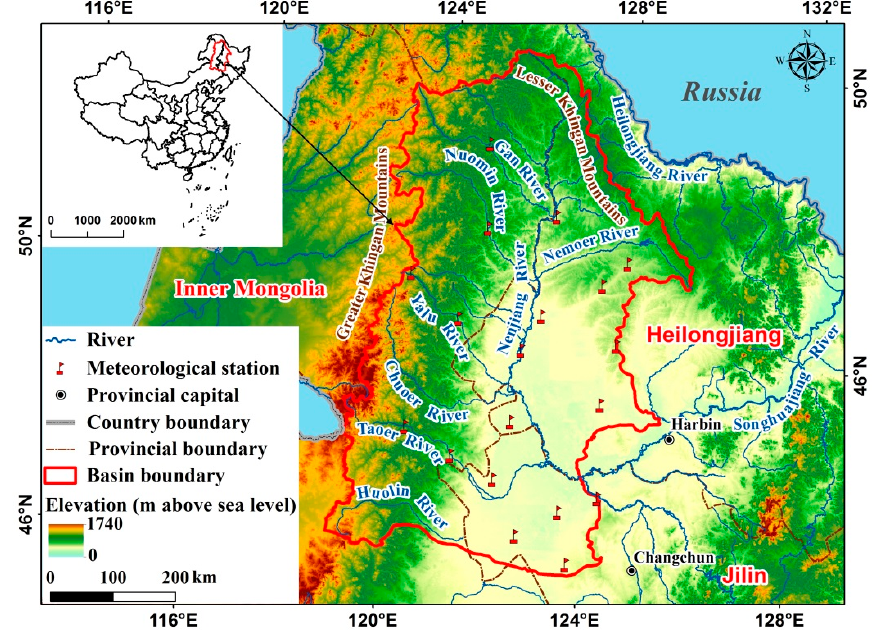
Figure 1. Geographic location and general situation of the Nenjiang watershed.